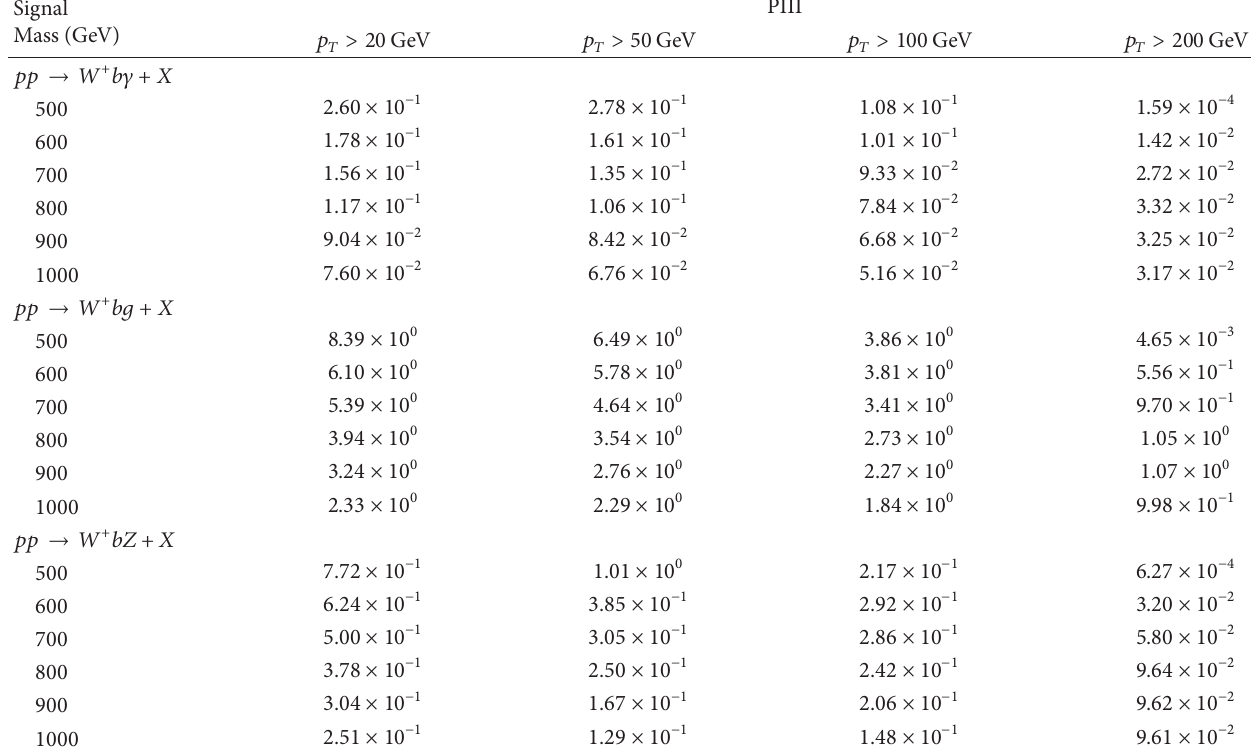
Table 9: The same as Table 7, but for parametrization